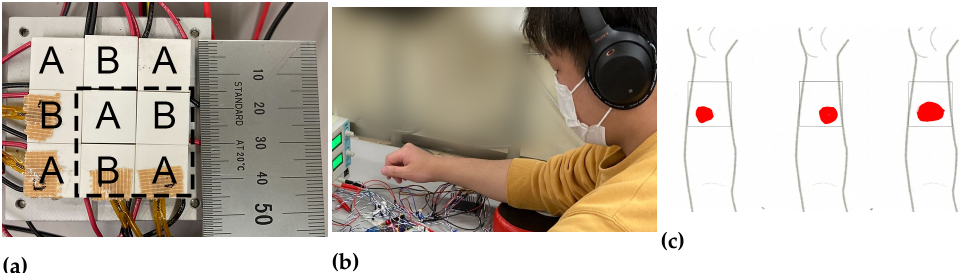
Figure 4. Experiment setup of spatial distribution effect. ( a ) 3 × 3 tiled Peltier devices. The total size of Peltier devices was 45 mm 2 For 2 × 2 stimuli, the total size was 30 mm 2 ( b ) System overview of the experiment about spatial distribution effect. As an adaptation temperature, we set 33 °C. To adapt to the temperature, the participants kept their hands on the device for three minutes. As a cooling/warming temperature target, we set 20 and 40 °C for each. ( c ) Participant’s drawing examples of the pain